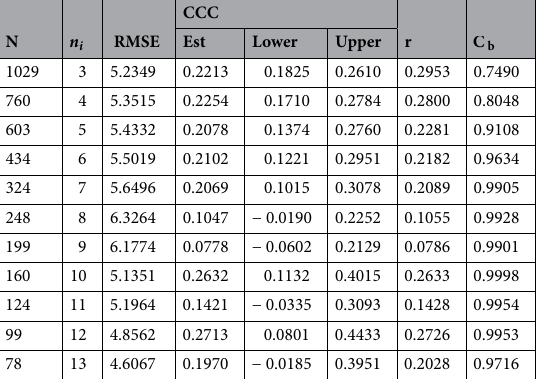
Table 4. Evaluation of one-step-ahead forecast prediction based on root mean square error (RMSE), concordance correlation (CCC), Pearson correlation (r), and accuracy ( C ) b ) coefficients between the predict and observed values of a new group with N women whom have n i observed